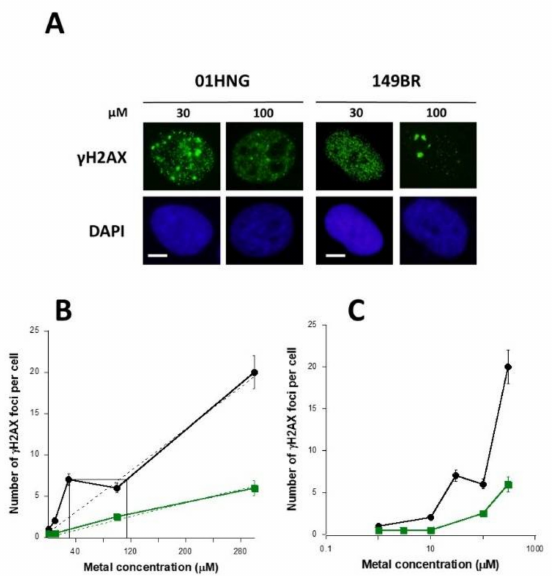
Figure 6. Evidence of an HRS-like phenomenon in cells exposed to metal. ( A ) Representative examples of images stained with anti- γ H2AX antibody and counterstained with DAPI after 24 h exposure to 30 or 100 µ M AlCl 3 in the human radiosensitive 01HNG and the radioresistant 149BR skin fibroblast cells. ( B , C ) Number of γ H2AX foci per cell in the 01HNG (black) and 149BR (green) cells after incubation for 24 h with the indicated concentration of AlCl 3 presented in a linear ( B ) or a semi-log ( C ) scale. Each plot represents the mean ± standard error (SEM) of at least three replicates. Dotted lines represent linear data